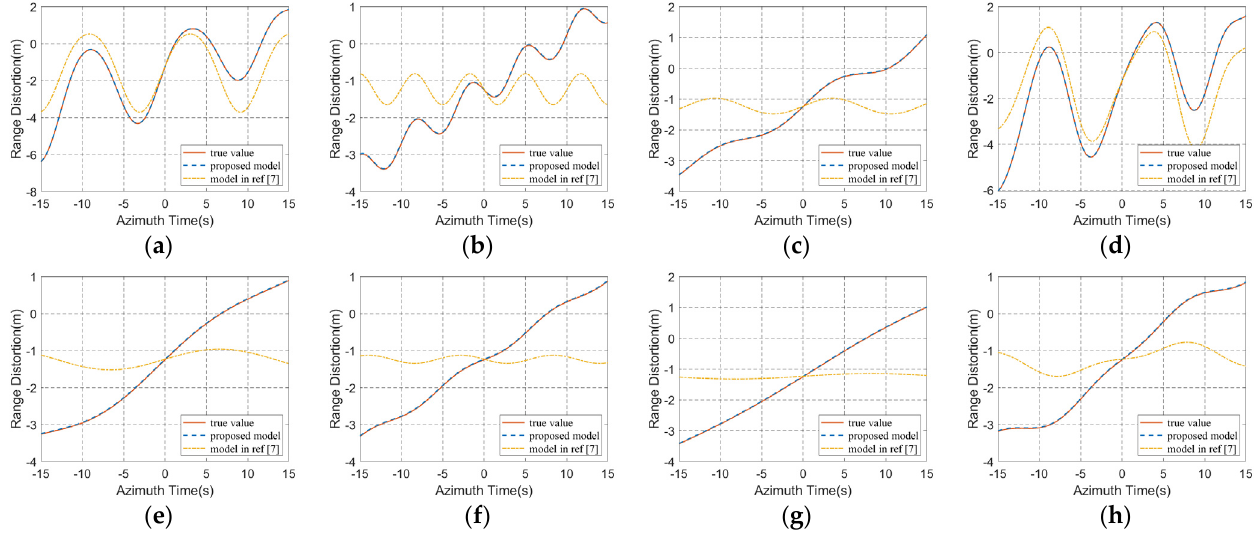
Figure 8. The range distortions of point P caused by ship angular oscillations . ( a ) Destroyer, roll motion; ( b ) destroyer, pitch motion; ( c ) destroyer, yaw motion; ( d ) destroyer, all the three angular oscillations; ( e ) carrier, roll motion; ( f ) destroyer, pitch motion; ( g ) destroyer, yaw motion; ( h ) carrier, all the three angular oscillations. Red solid lines represent the true values of the range distortions obtained by numerical calculation. Blue dotted lines are the results obtained by proposed model, which are basically coincide with the red lines. Yellow dot-dash lines are the results obtained by the model in reference [7].